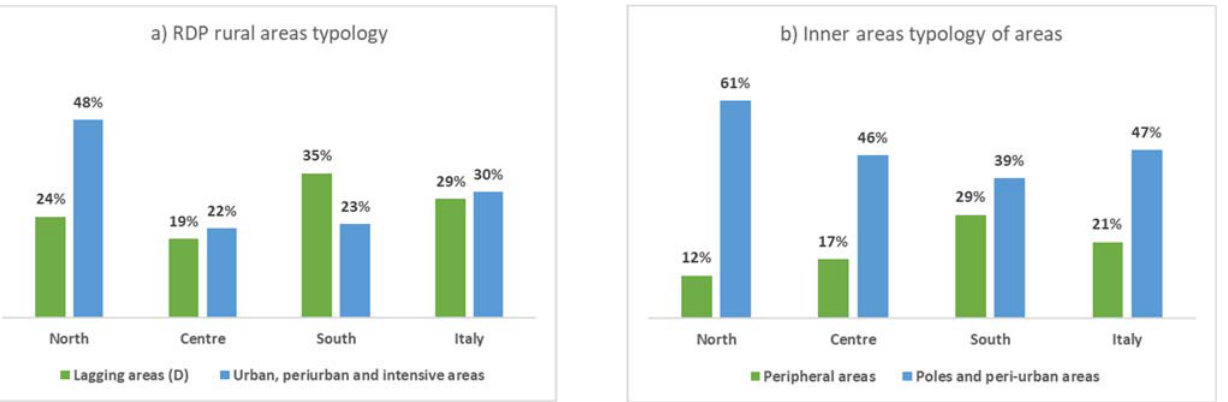
Figure 7. Percentage of total committed expenditures in Italy allocated by types of areas according to the two institutional typologies. Definition ( a ): RDP rural areas; definition ( b ): IAS rural areas. Source: authors’ elaborations from the data base of funded investment projects.